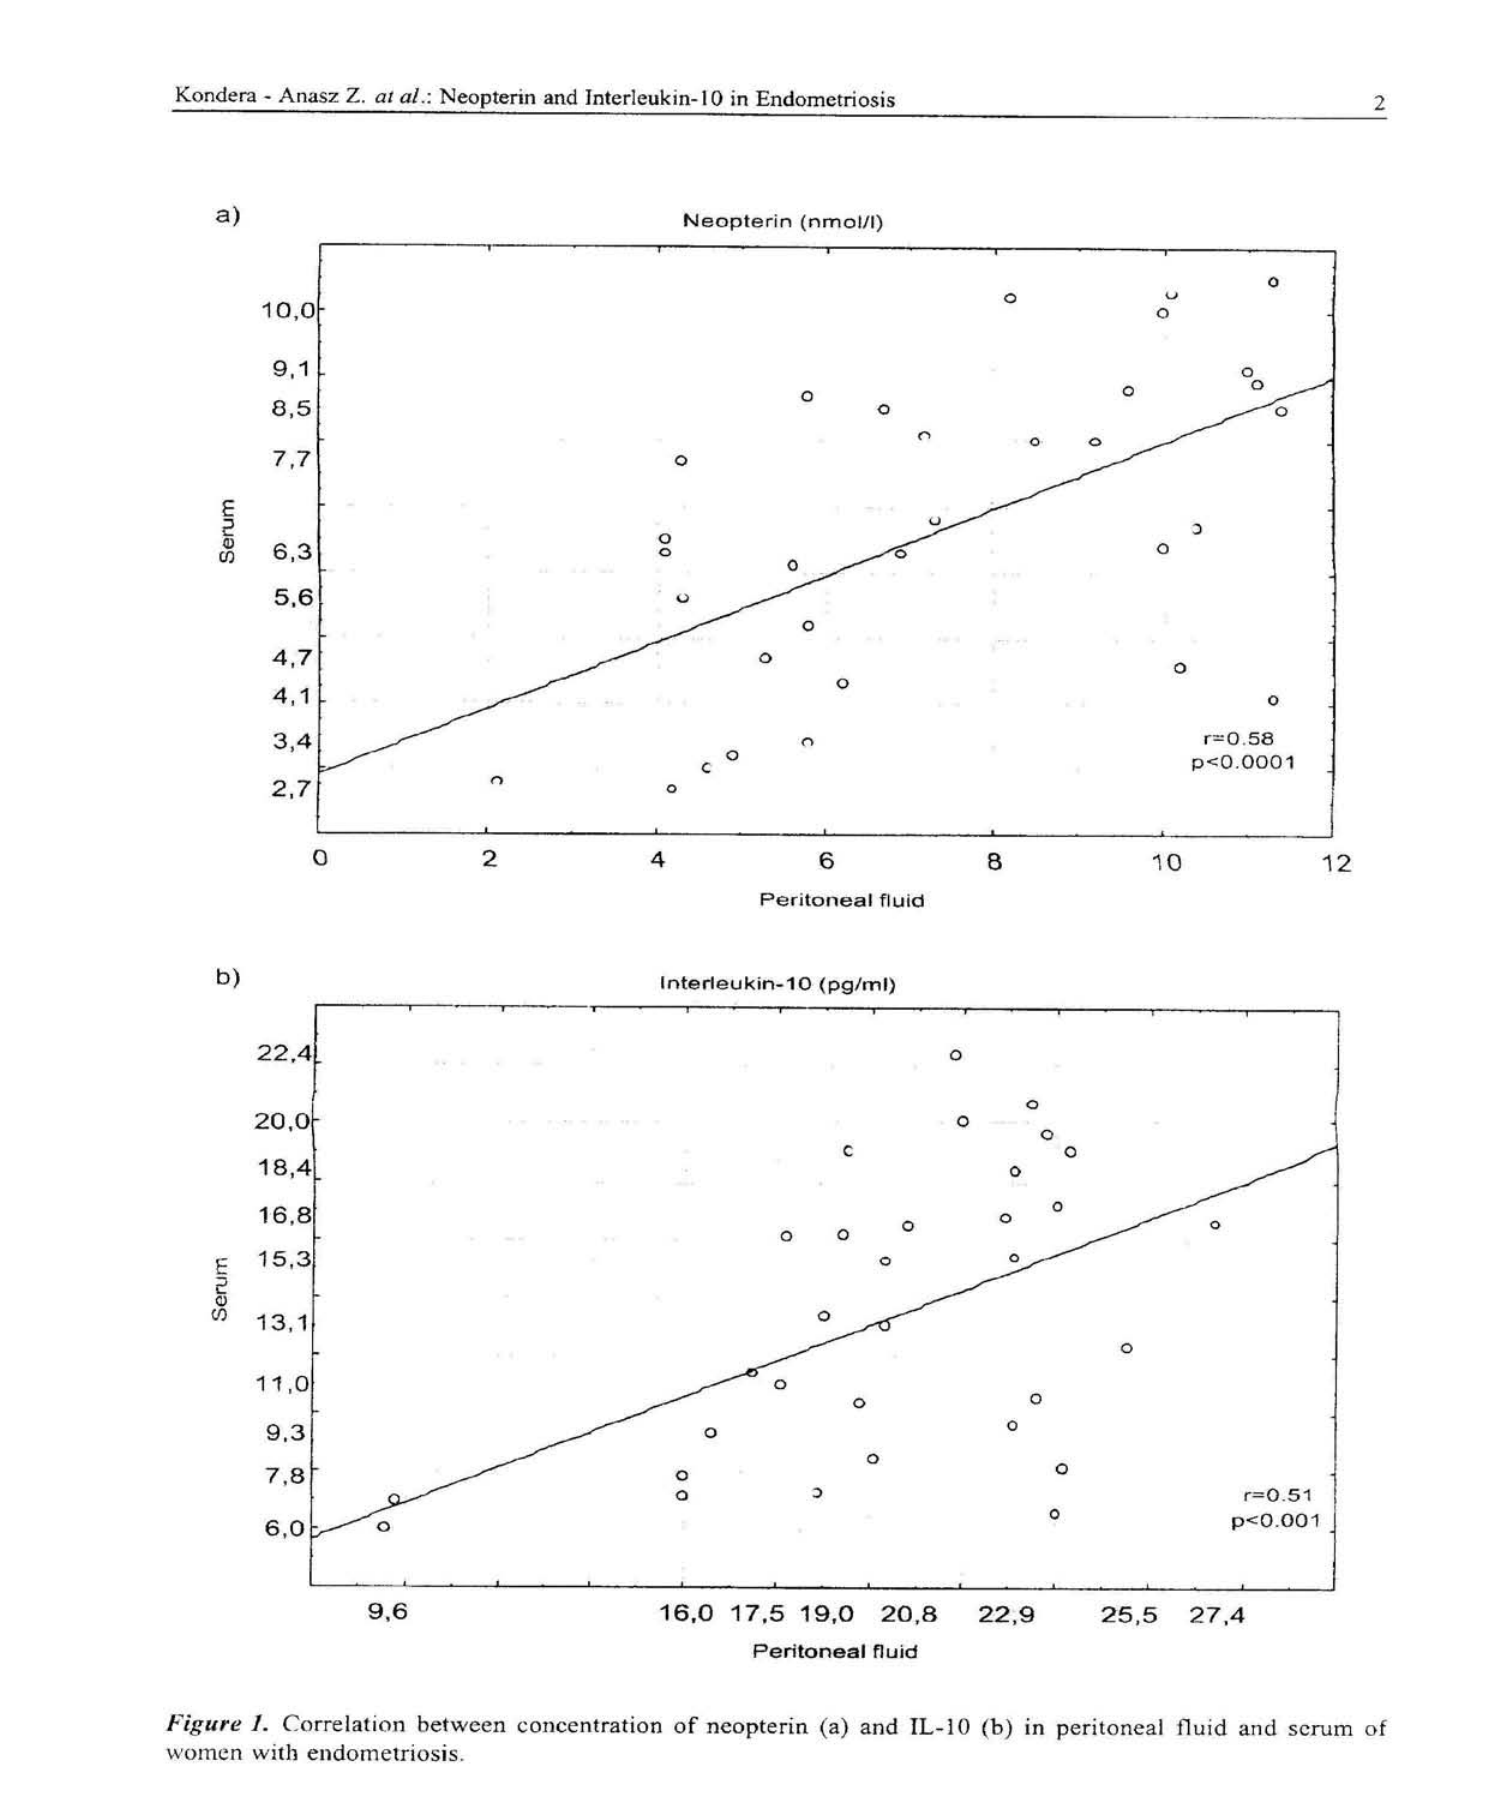
Figure 1. Correlation between concentration of neopterin (a) and IL-10 (b) in peritoneal fluid and serum of women with